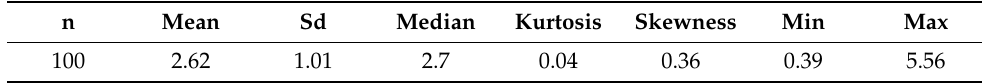
Table 7. Descriptive statistics of the carbon fibers data.